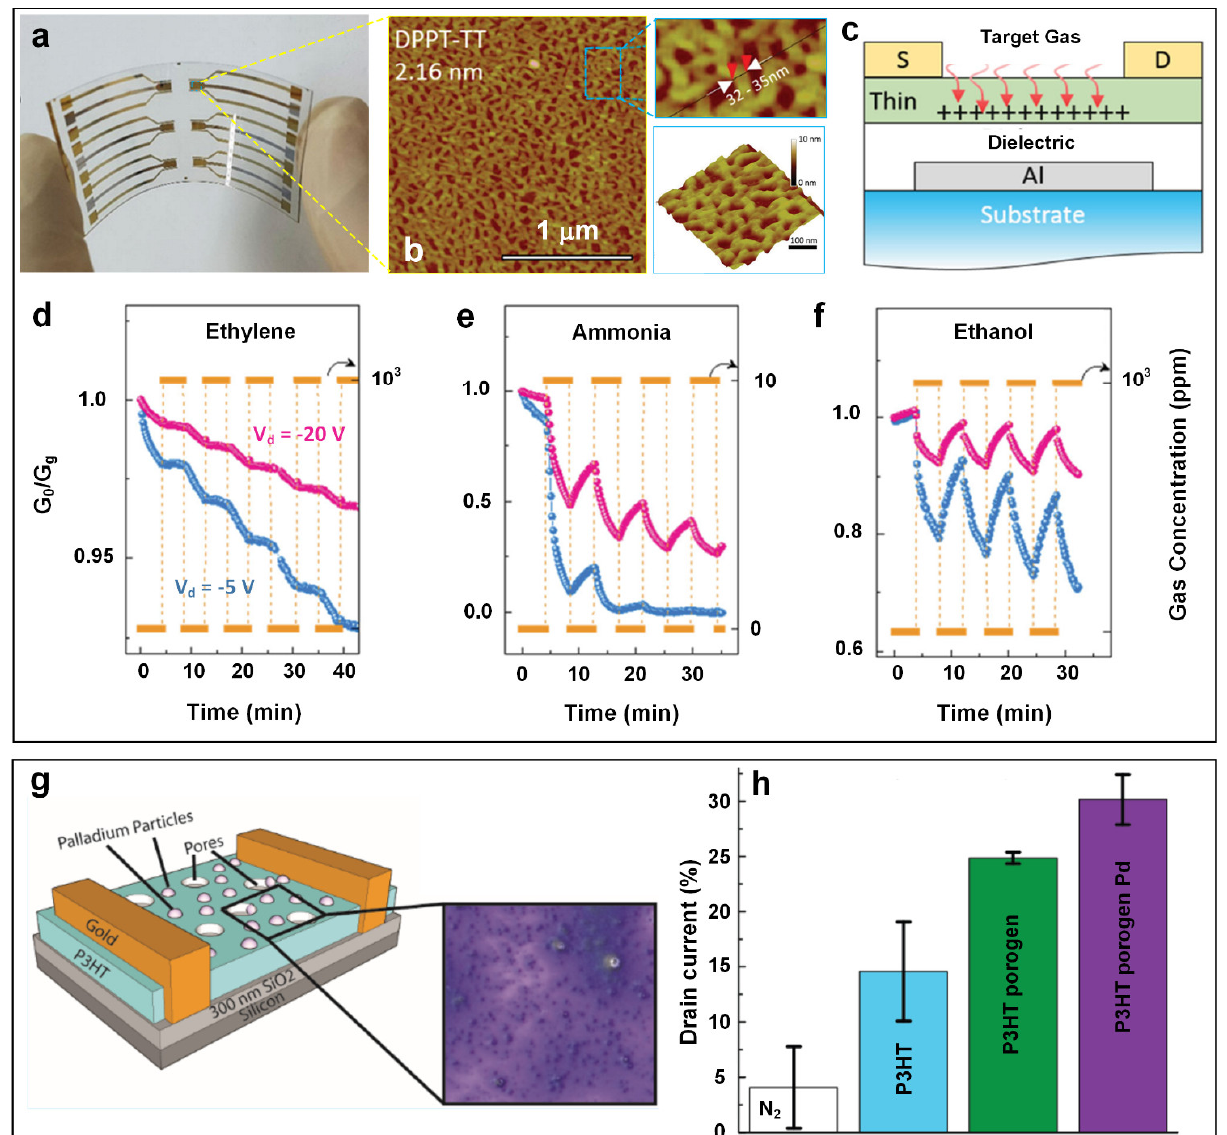
Figure 6. ( a ) Photographic image of the DPPT-TT thin-film-printed flexible gas sensor on transparent PEN substrate and ( b ) the corresponding AFM images of a typical DPPT-TT film. ( c ) Schematic illustration of the thinner OFETs for ethylene gas detection and the corresponding sensing dynamic curves of ( d ) ethylene, ( e ) ammonia, and ( f ) ethanol gases. Reproduced from Ref. [72] with permission from Wiley. ( g ) Schematic of Pd-decorated porous P3HT OFET sensor with the top view as inset. ( h ) The gradually improved response after stepwise modifications. Reproduced from Ref. [46] with permission from the American Chemical